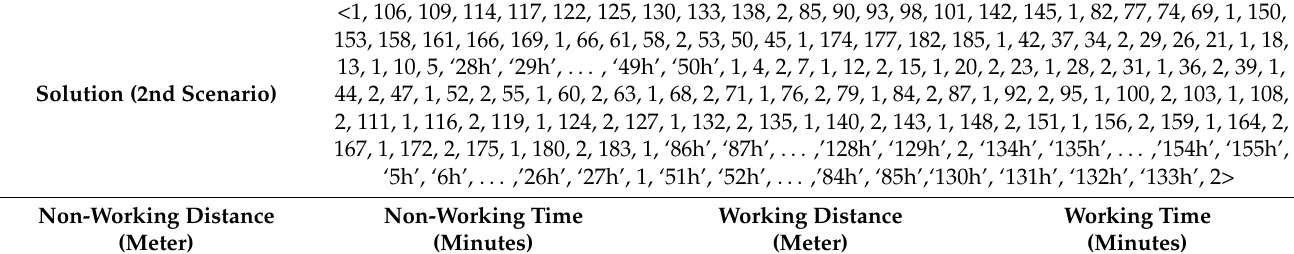
Table 7. The optimized field coverage plan with the results of the simulation model for fertilizing operation by using three homogenous robots with the capacity of 0.8 m 3 in the sample field (2 nd scenario).